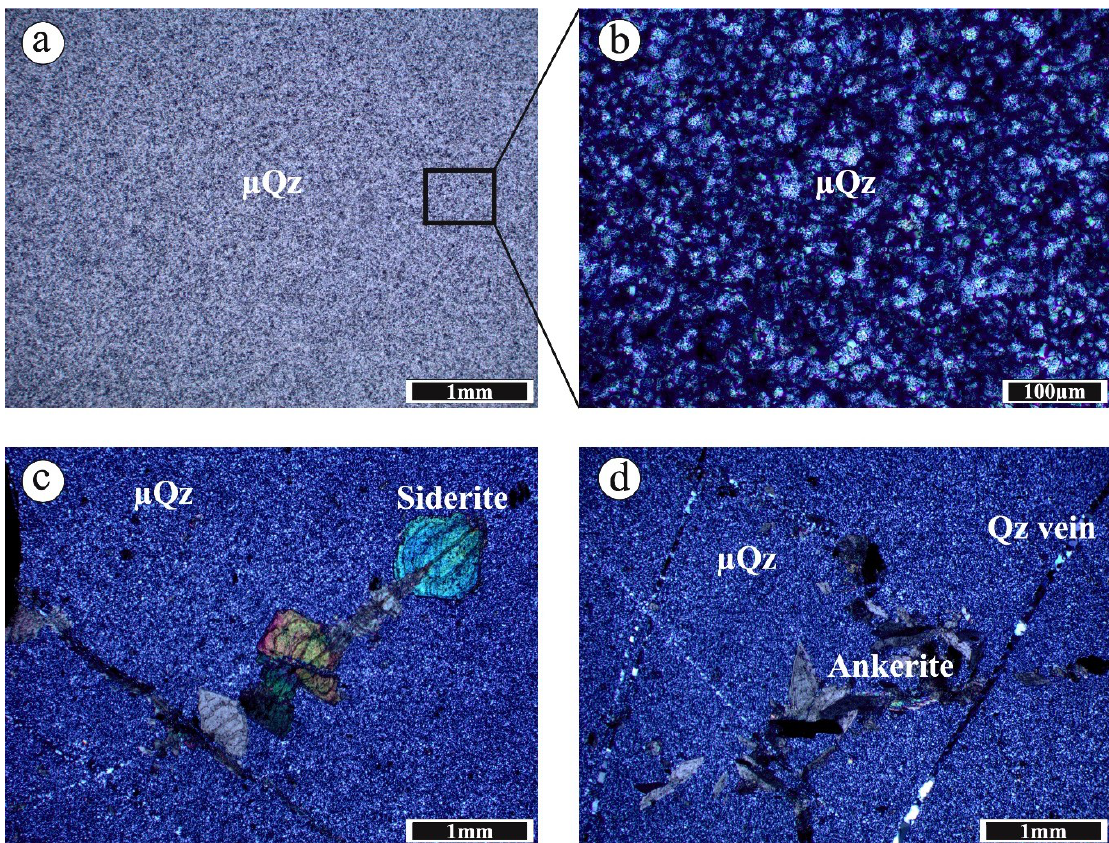
Figure 6. Optical microscopy for massive white chert samples. µQz = microquartz. ( a ) and ( b ) show the purity and homogeneity of massive white chert. They are entirely composed of microquartz of 5 µm in average size. ( c ) and ( d ) All layers are cross-cut by thin quartz-filled veins (< 0.5 µm) commonly associated with siderite ( c ) and ankerite ( d ) secondary minerals.